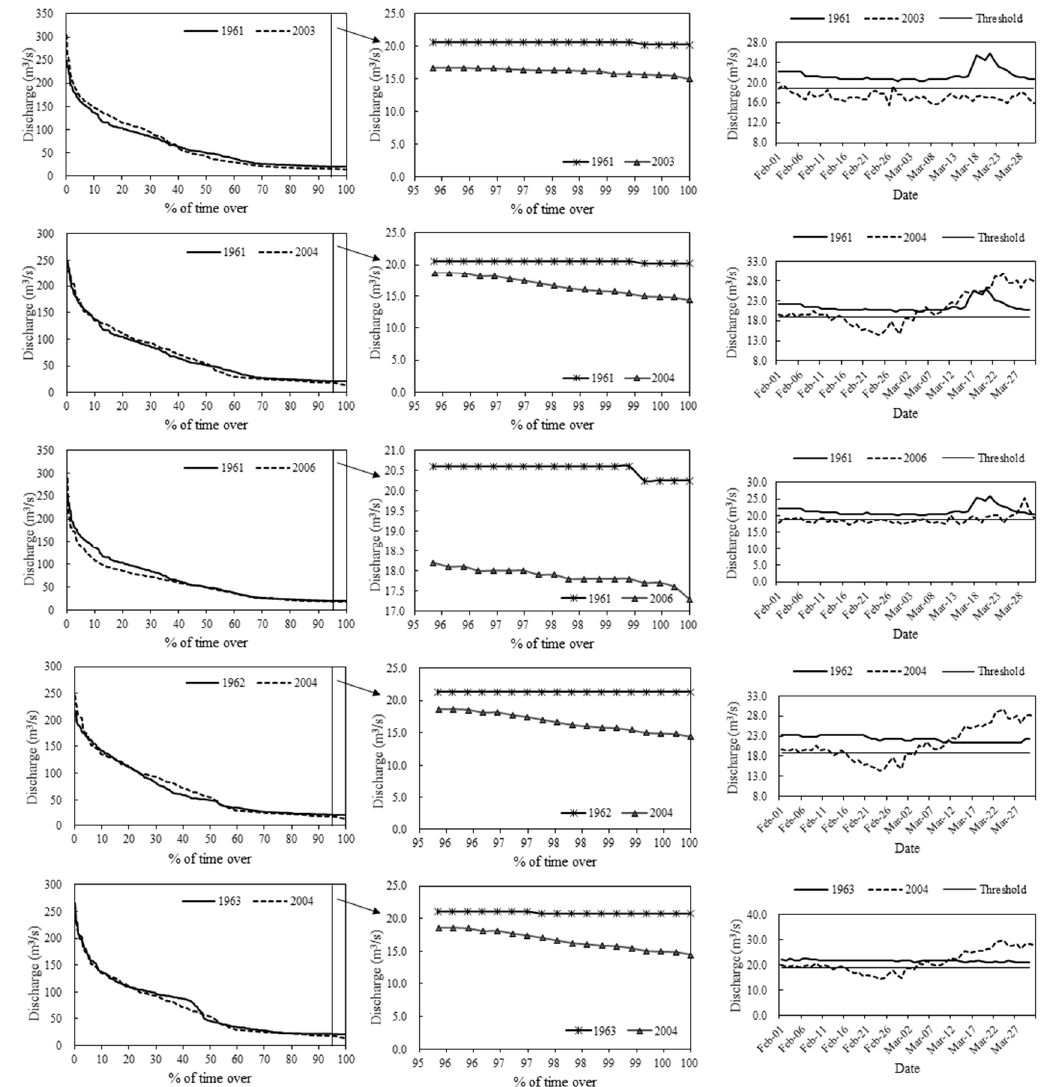
Figure A4. Flow duration curves for all selected pairs in Phase 1 and Phase 5.